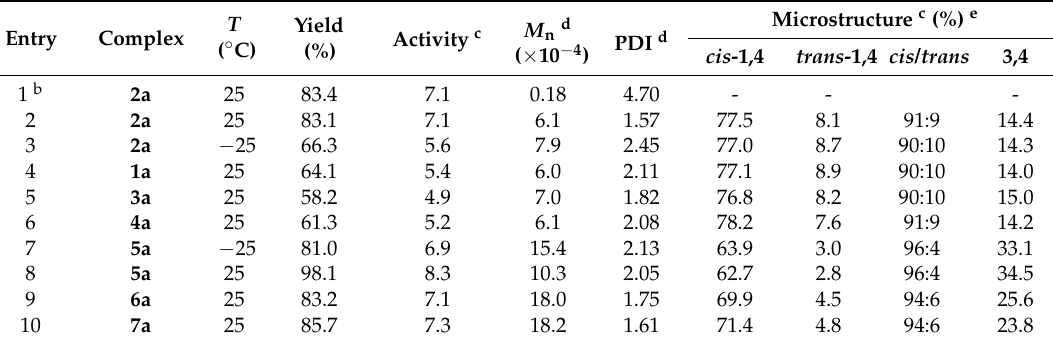
Table 1. Isoprene polymerization results with Fe(II) catalyst a .